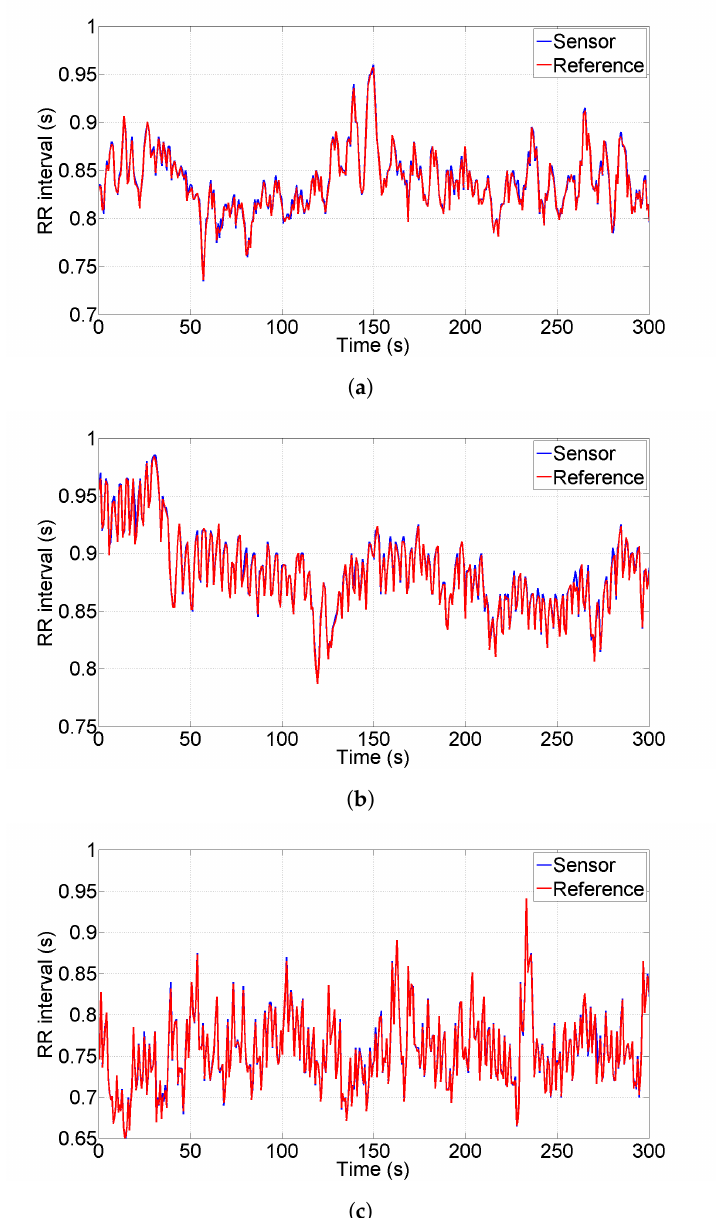
Figure 8. Comparison of Tachograms extracted acquiring data with the proposed sensor and with a reference one on three different individuals ( a – c ): blue lines represent the proposed sensor, red lines represent the reference